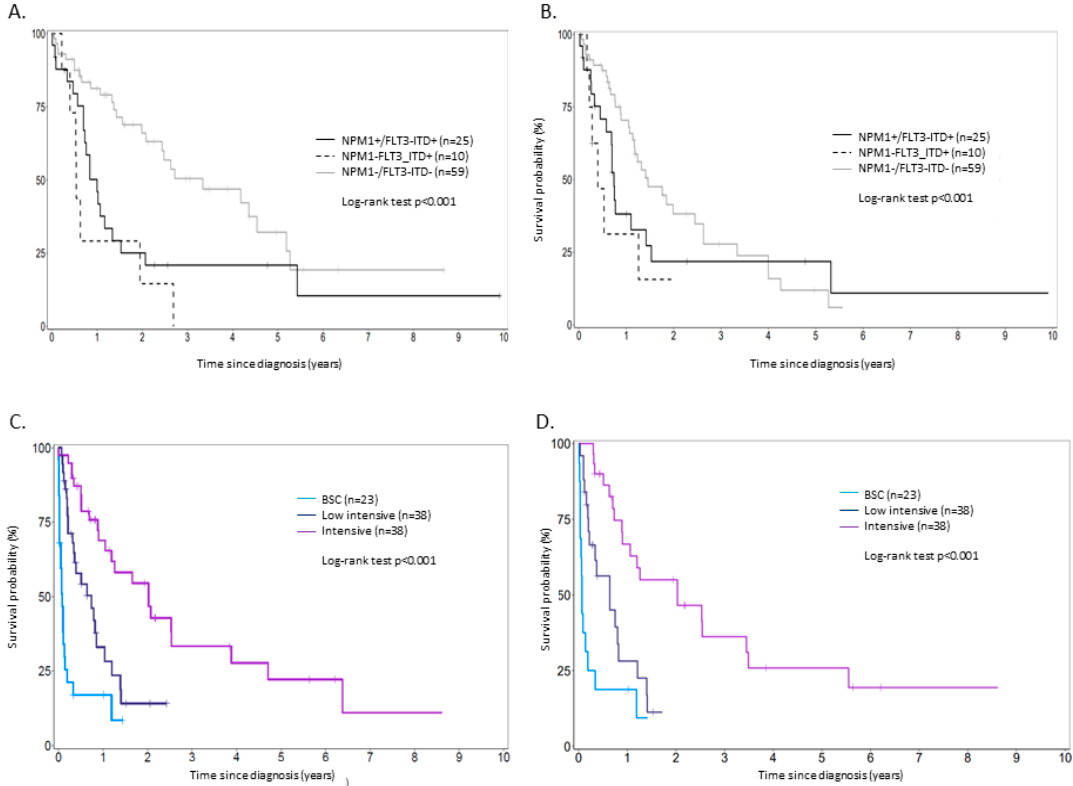
Figure 1. ( A ) Overall and ( B ) progression free survival of NK NPM1 +/ FLT3-ITD + , NPM1 − / FLT3-ITD + and NPM1 − / FLT3-ITD − patients treated intensively. ( C ) Overall and ( D ) progression-free survival of intermediate abnormal karyotype patients (independently of NPM1 / FLT3-ITD status) according to treatment intensity.